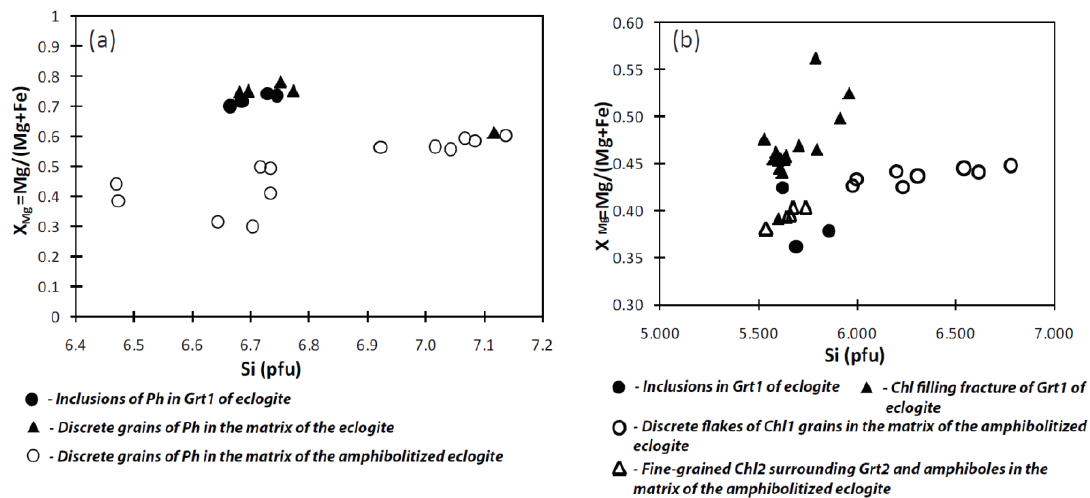
Figure 8. ( a ) Chemical composition of phengite from eclogites and amphibolitized eclogite. ( b ) Chemical composition of chlorite from eclogites and amphibolitized eclogite. composition of chlorite from eclogites and amphibolitized